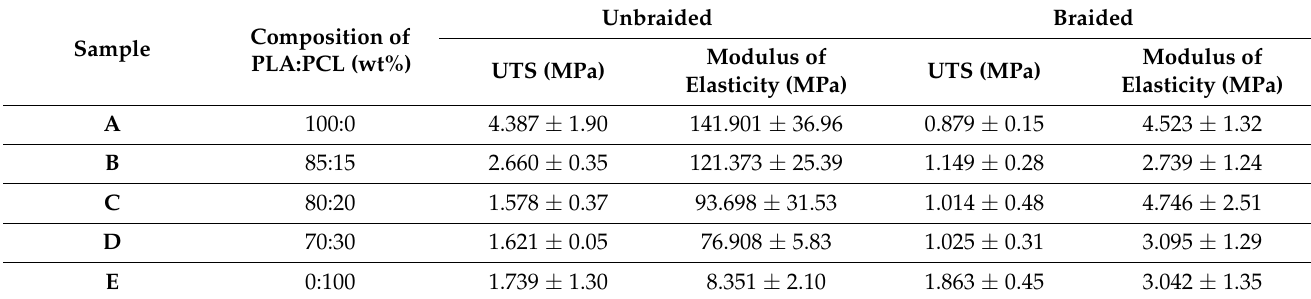
Table 3. The results of tensile strength of the samples.